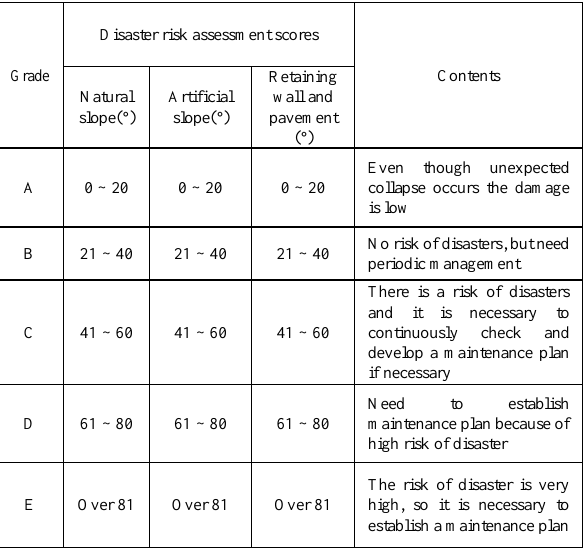
Table 1. Assessment scores and contents by